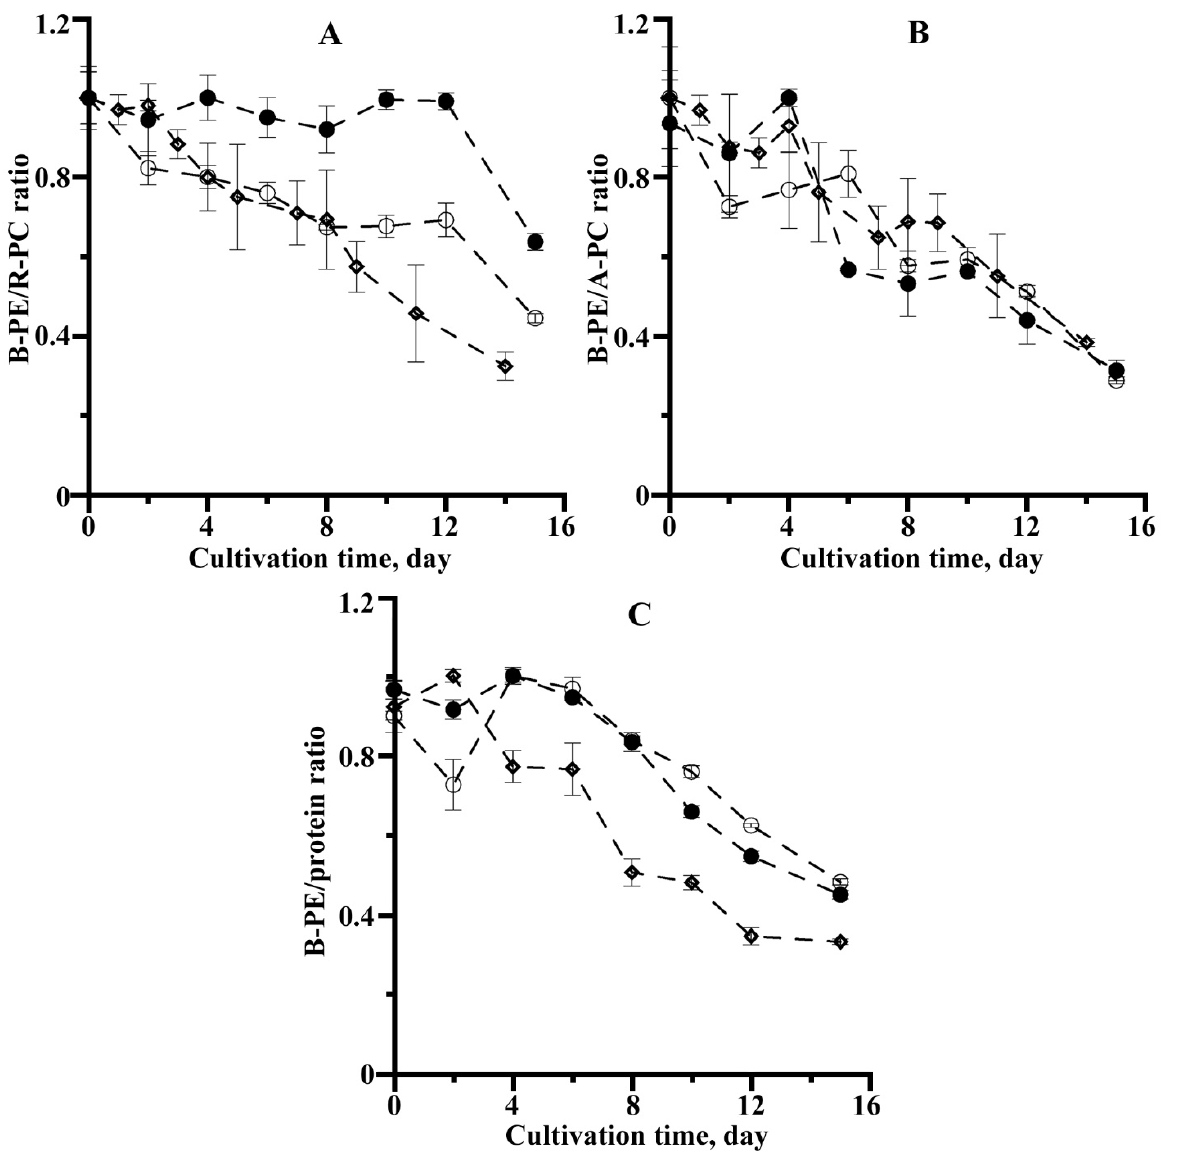
Figure 4. B-phycoerythrin/R-phycocyanin ( А ), B-phycoerythrin/Allophycocyanin ( B ), and B-phycoerythrin/protein ratio ( C ) normalized by maximum values of P . purpureum culture under the different methods of carbon introduction into photobioreactor: ● –additional introduction СО 2 ; ○ –air